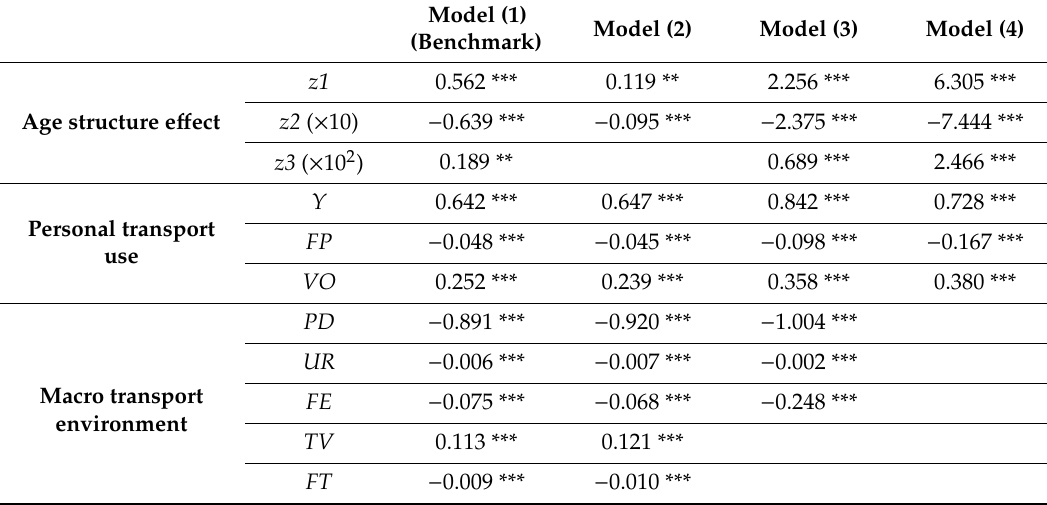
Table 3. Estimation Results: Models